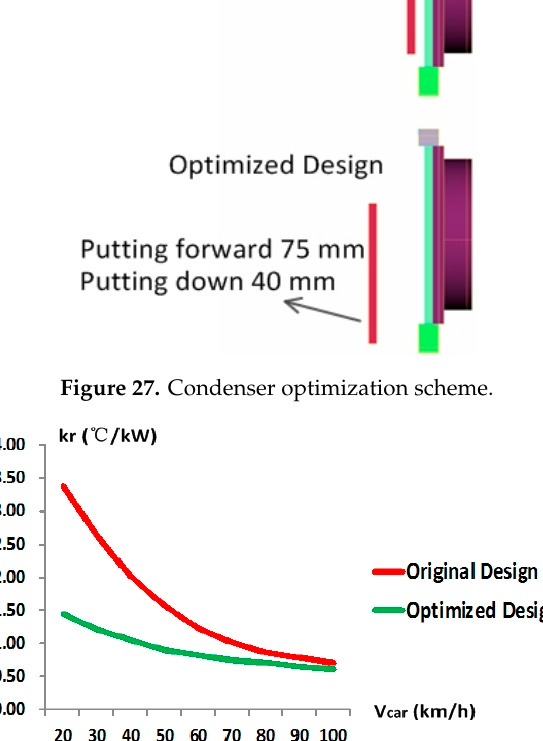
Figure 28. Radiator coupling factor optimization.